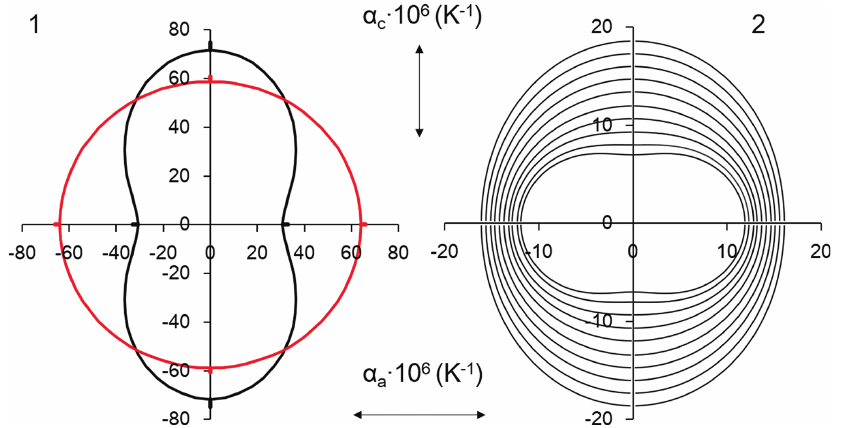
Figure 6: Thermal expansion diagrams for hydroxyapatite obtained by sol-gel method (1) (black line – before transition, red line – after transition) and solid-state reaction (2).